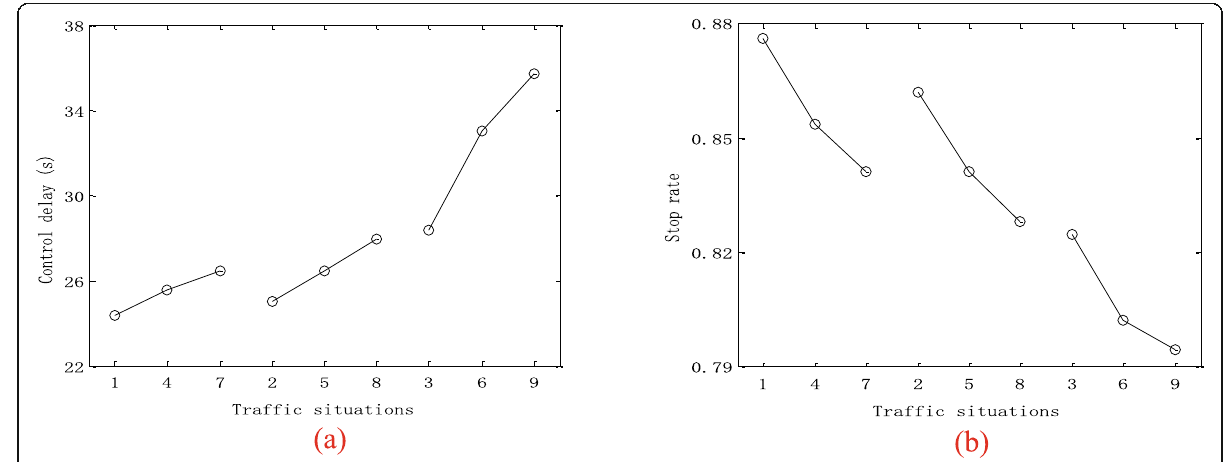
Fig. 3 Comparison of vehicle delays and stop rates at different road section speeds with the same mixed proportion of electric vehicles. a Comparison of vehicle delay. b Comparison of vehicle stop